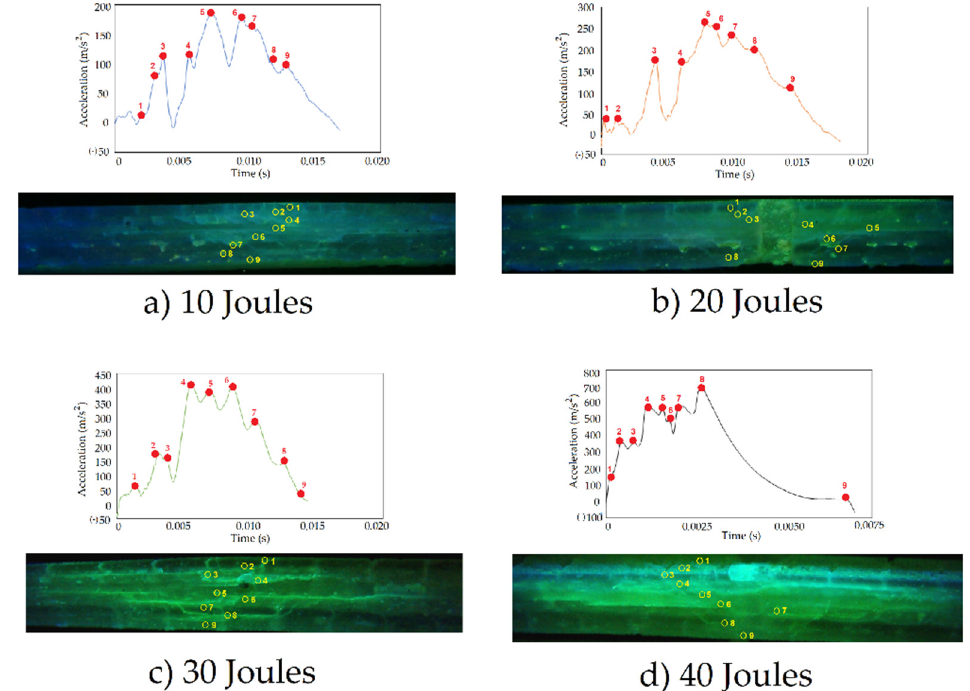
Figure 13. Analysis of the acceleration (m/s 2 ) and its relationship with the damage presented in the cross section using fluorescent light at ( a ) 10 joules, ( b ) 20 Joules, ( c ) 30 Joules and ( d ) 40 Joules.